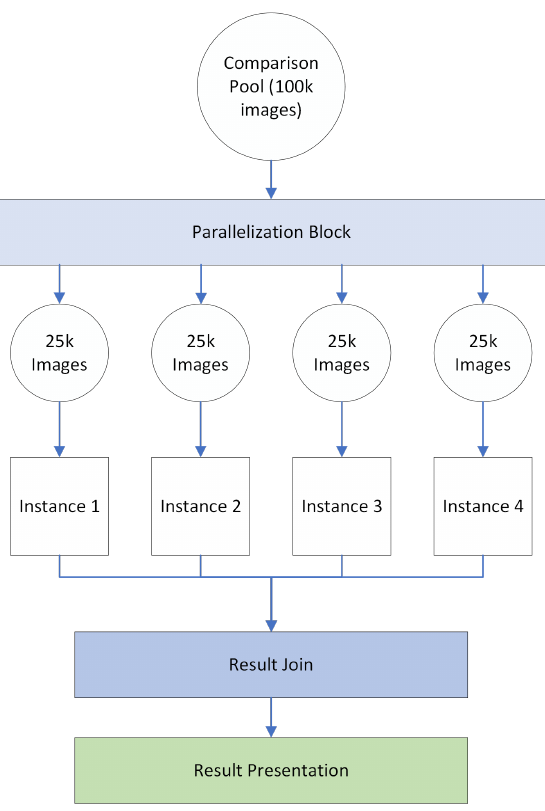
Figure 3. Multi-instance